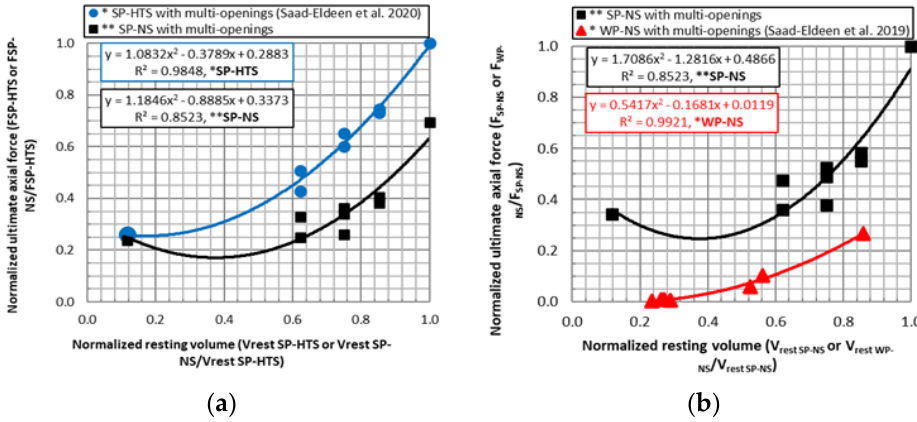
Figure 19. Normalised ultimate force vs. normalised resting volume for stiffened specimens of ordinary and high-tensile steel SP-HTS [18] ( a ) and stiffened/unstiffened ordinary steel specimen WP-NS [15] ( b ). Table 3. Comparison between ** SP-NS and * SP-HTS